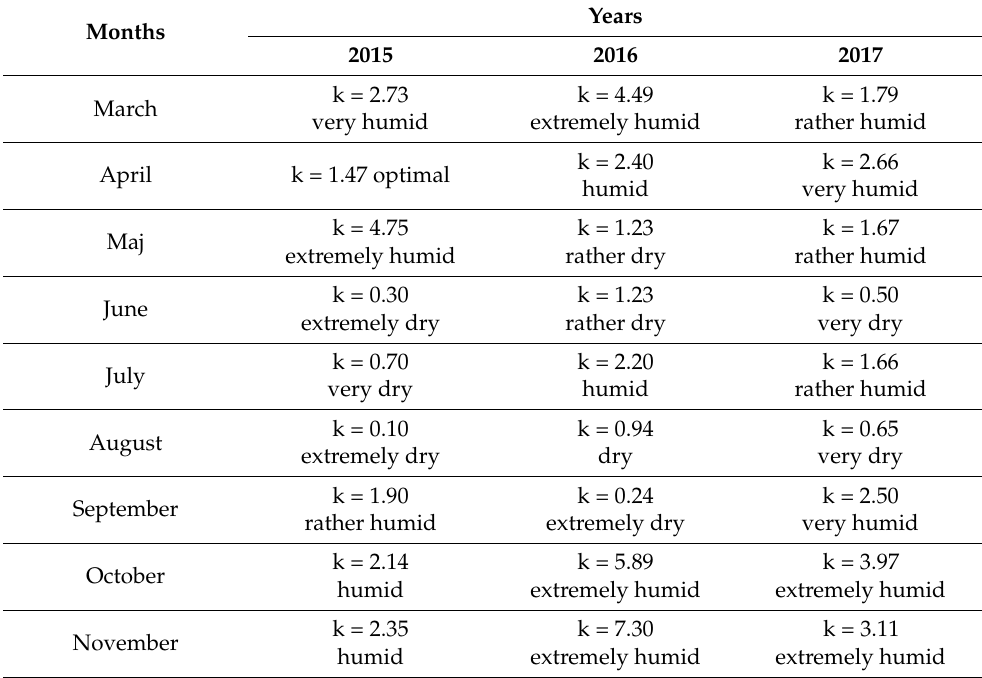
Table 3. Selyaninov hydrothermal coefficients (K) during the growing seasons in the years of the